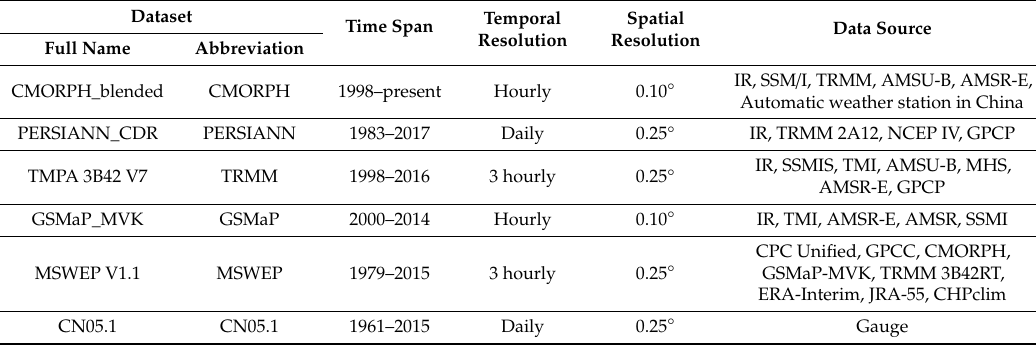
Table 2. Brief introduction of precipitation datasets in this